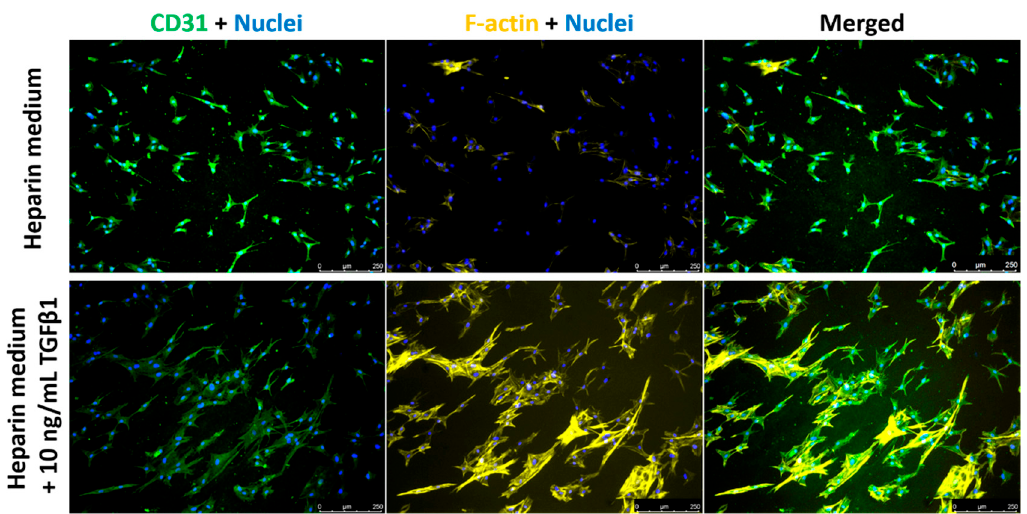
Figure 6. Fluorescent images of VECs in VEC single-culture model. CD31—Green; F-actin—Yellow; Nuclei—Blue. Scale bar: 250 µm.